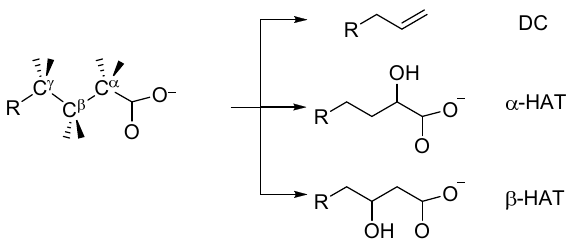
Scheme 1. Reaction products observed for fatty acid activation by P450 OleT JE .